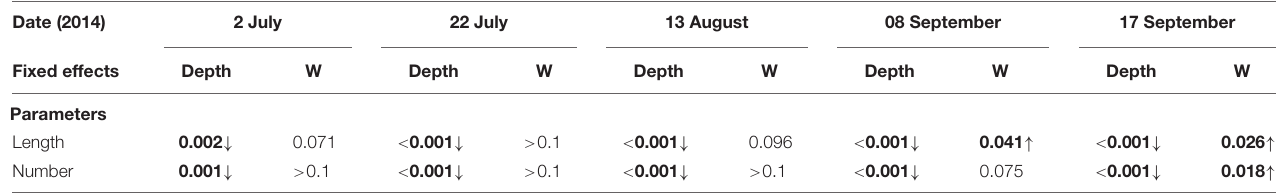
TABLE 5 | P -values for differences of Least Squares Means (LSmeans) for main effects in each measurement campaign after exclusion of non-significant fixed effects from the model.